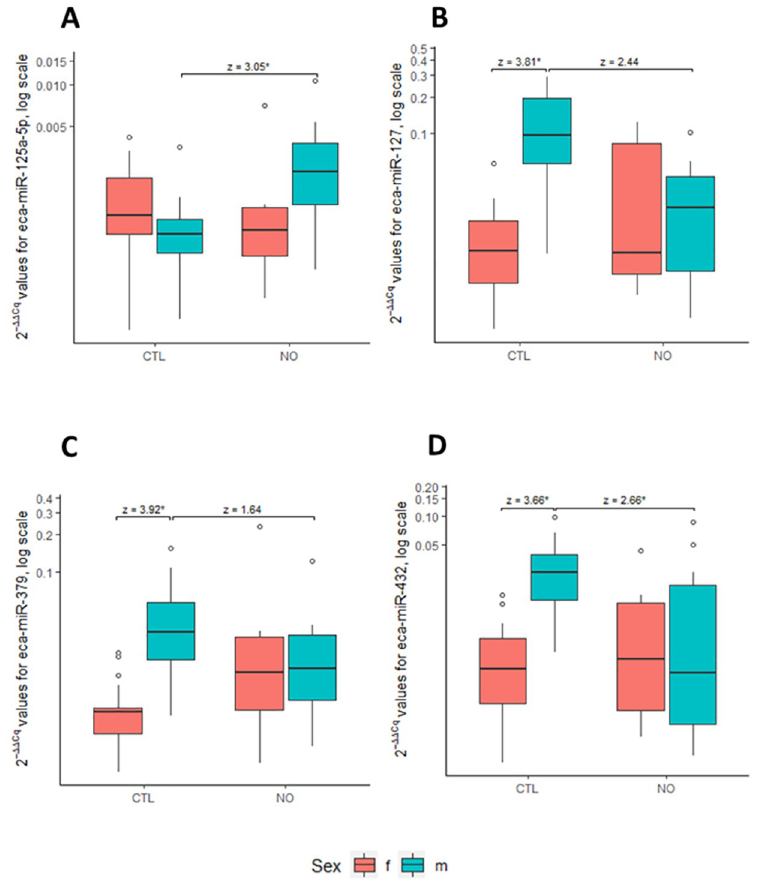
demonstrated the 2 - ΔΔ Cq values of the microRNA candidate on a log scale. The Kruskal-Wallis Multiple-Comparison Z-value (Dunn’s Test) with Bonferroni correction was reported and marked with an asterisk ( � ) when significant. Abbreviations: CTL = control, NO = new occurrence, m = male, f = female.